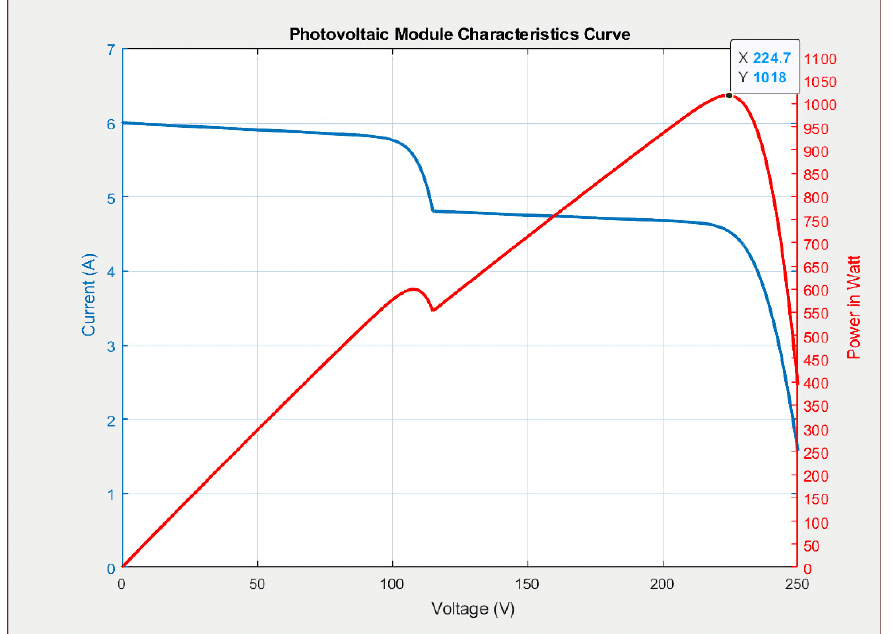
Figure 7. Simulated P–V and I–V characteristic curves for Case 2.